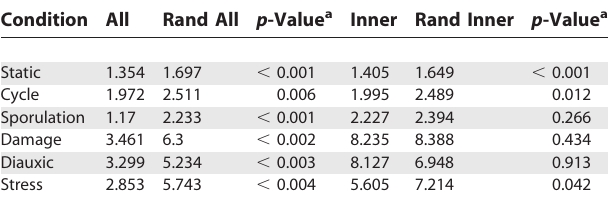
Table 4. Euclidean Distances of THub SPPs (3-Vertex Level) within Each Layer Condition All